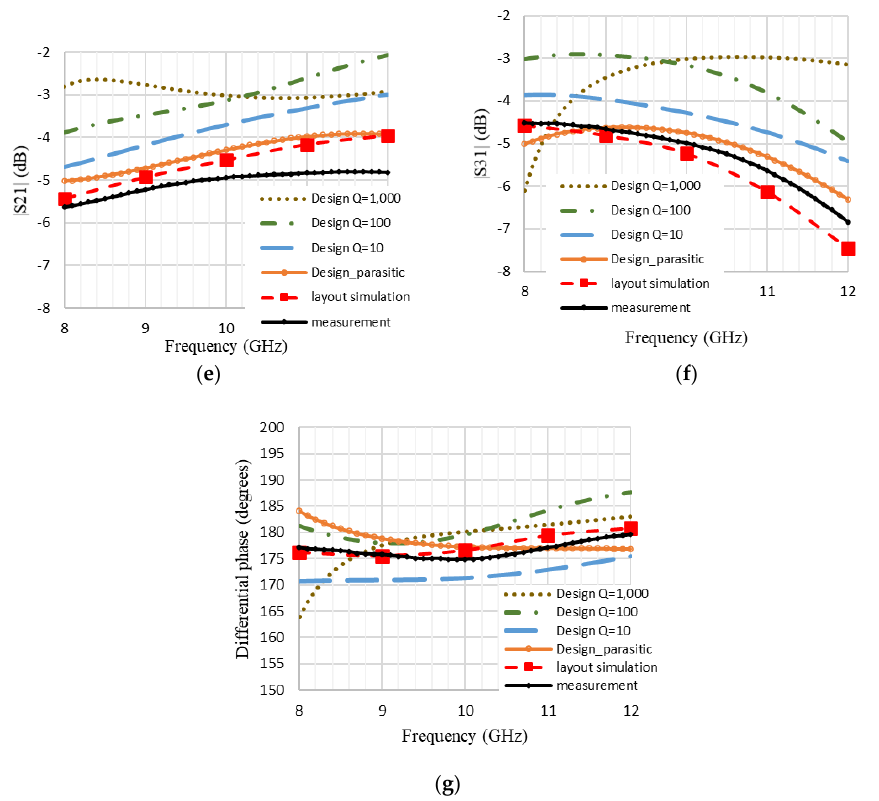
Figure 12. Frequency response of the simulated and measured balun. ( a ) |S11|, ( b ) |S22|, ( c ) |S33|, ( d ) |S23|, ( e ) |S21|, ( f ) |S31|, ( g ) differential phase output.